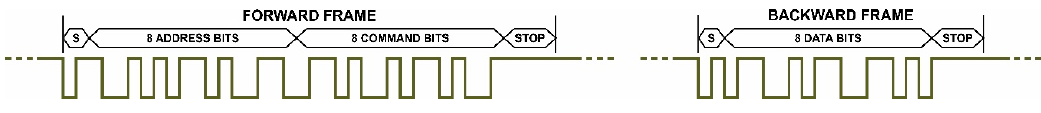
Figure 3. Format of the DALI frames.